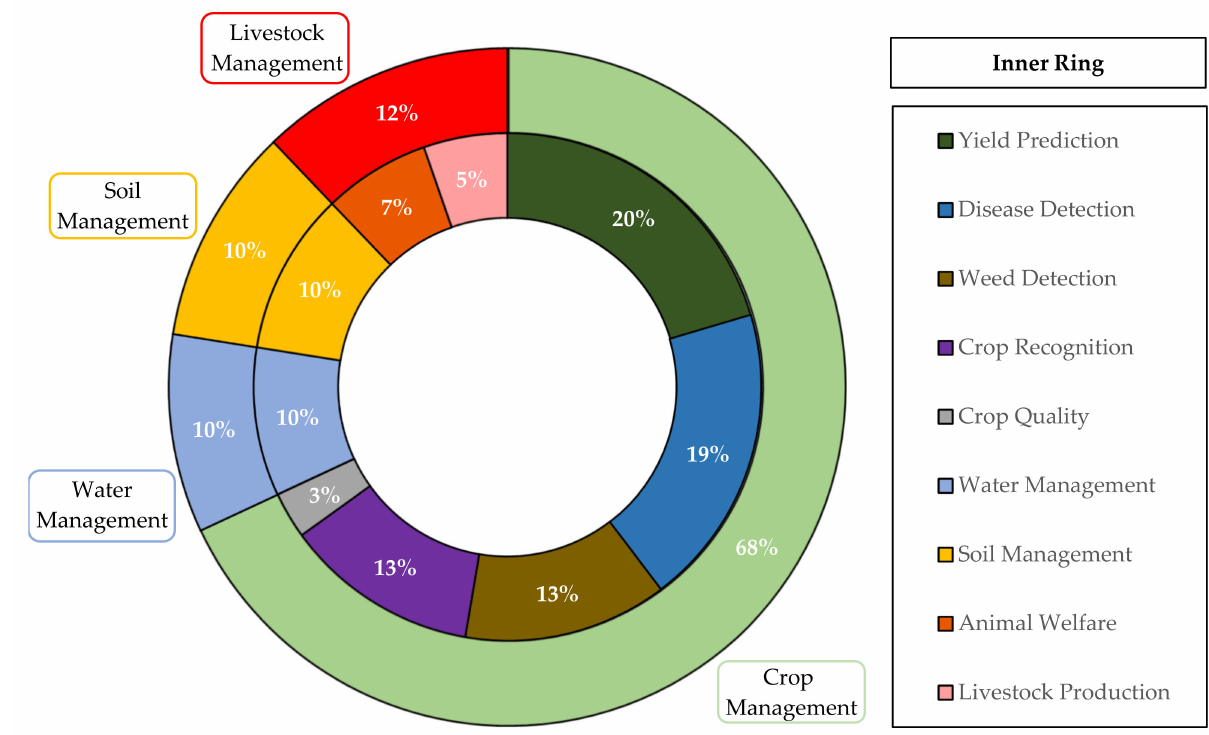
Figure 5. The classification of the reviewed studies according to the field of